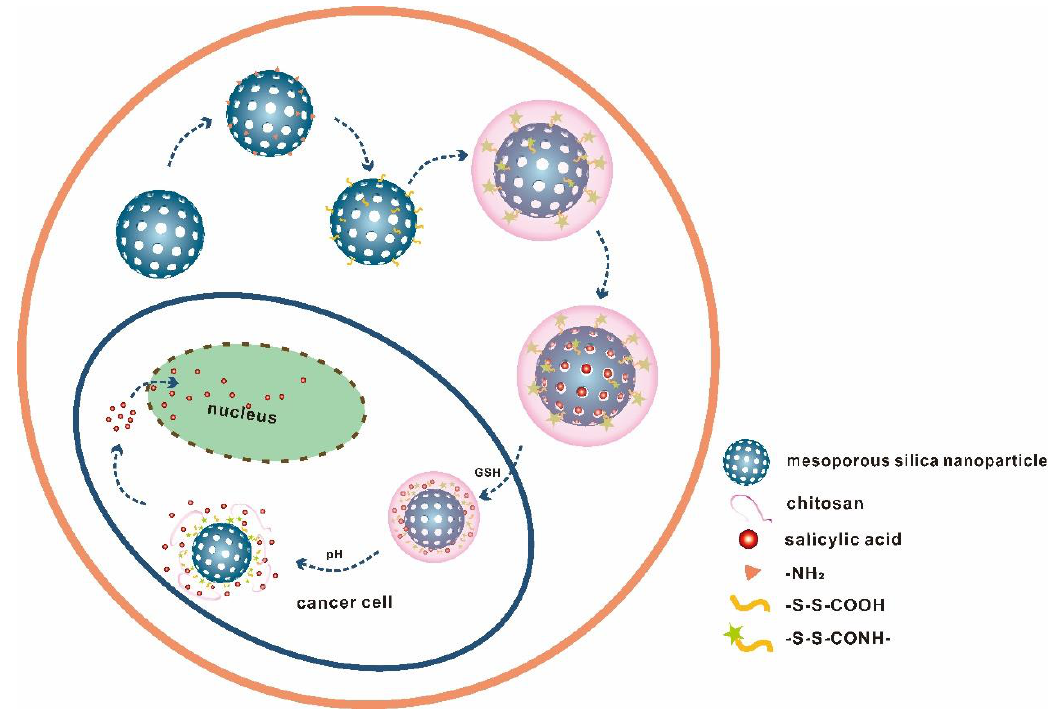
Figure 1. Schematic of the synthesis and responsive release of pH/redox double-reactive MSN-S-S-CS.